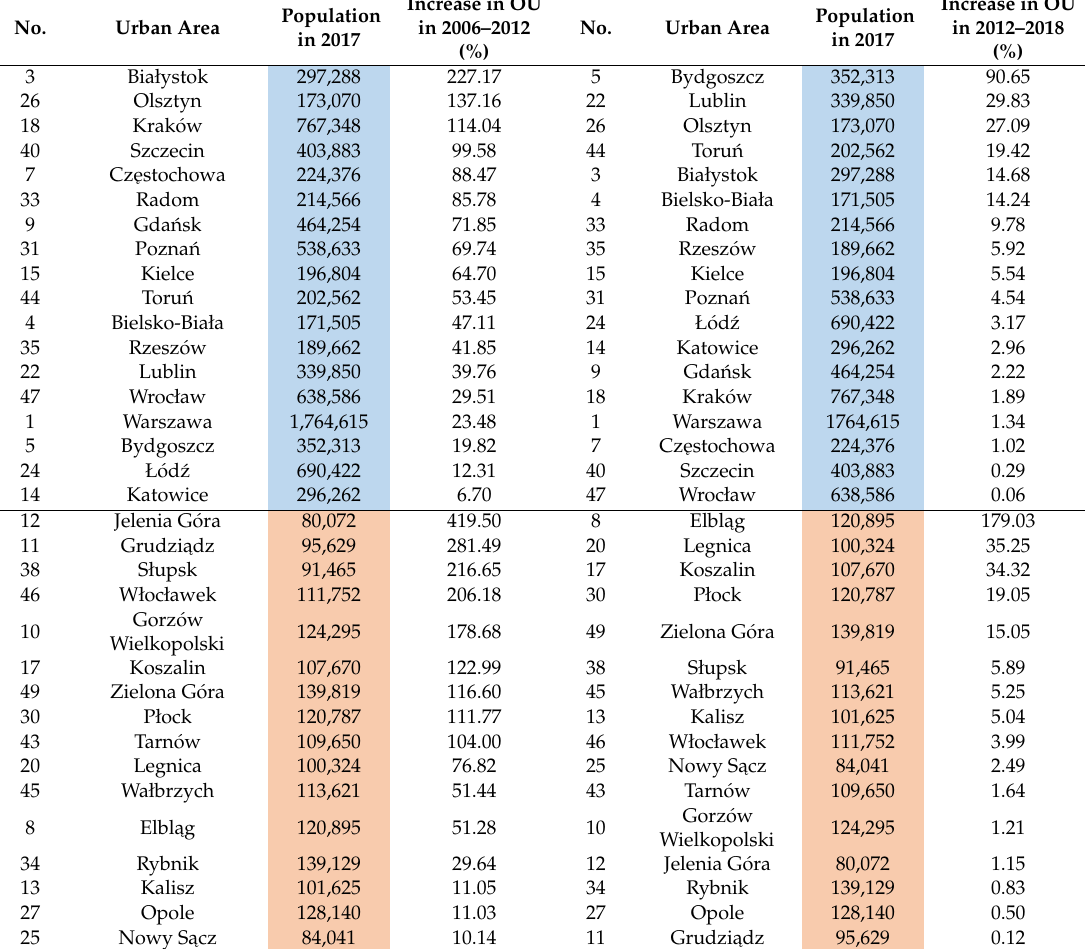
Table A4. Ranking of cities based on an increase in the values of the OU index in 2006–2012 and 2012–2018 and an increase in population. Demographic classes of cities have been marked in color. Big cities—blue, medium—orange,